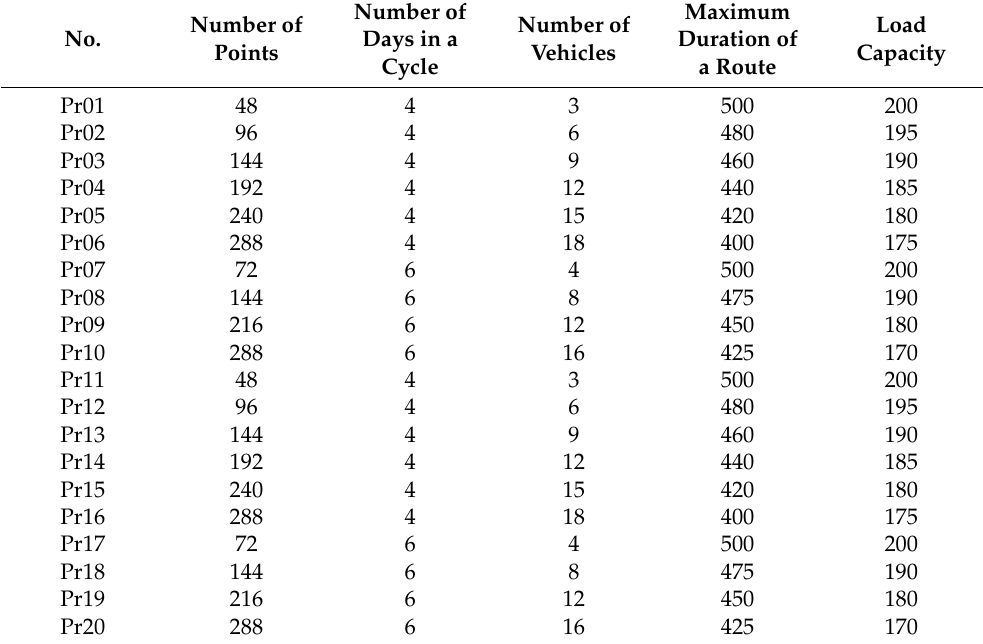
Table 2. The parameters of PVRPTW benchmarks.